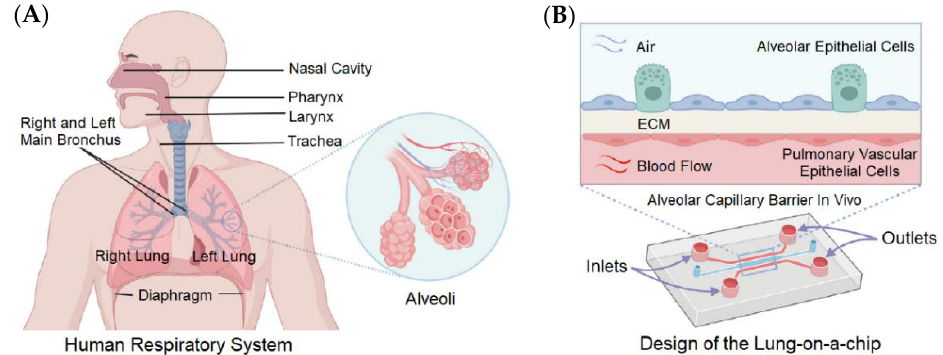
Figure 6. Alveolar–capillary barrier in vivo mimicked in a lung-on-a-chip model [78]. ( A ) The exchange of O 2 and CO 2 occurs in the human lungs, especially in the alveoli. ( B ) Cross-section of the lung model on microfluidic chip, where two different channels are separated by a thin, porous membrane. Reproduced with permission from Elsevier Copyright (2023).